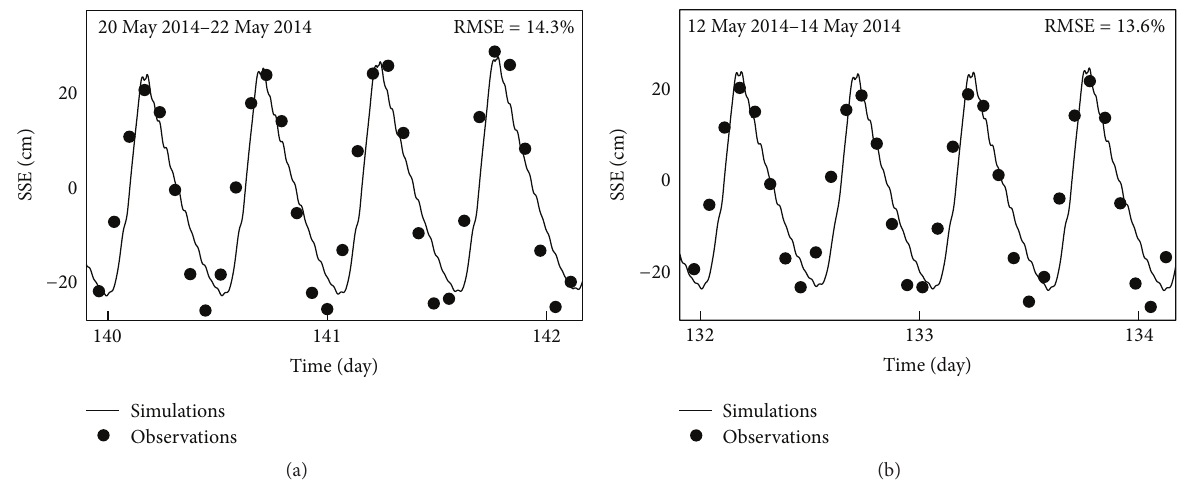
Figure 3: Predicted and observed SSE versus time for validation (b) and verification (a) period.